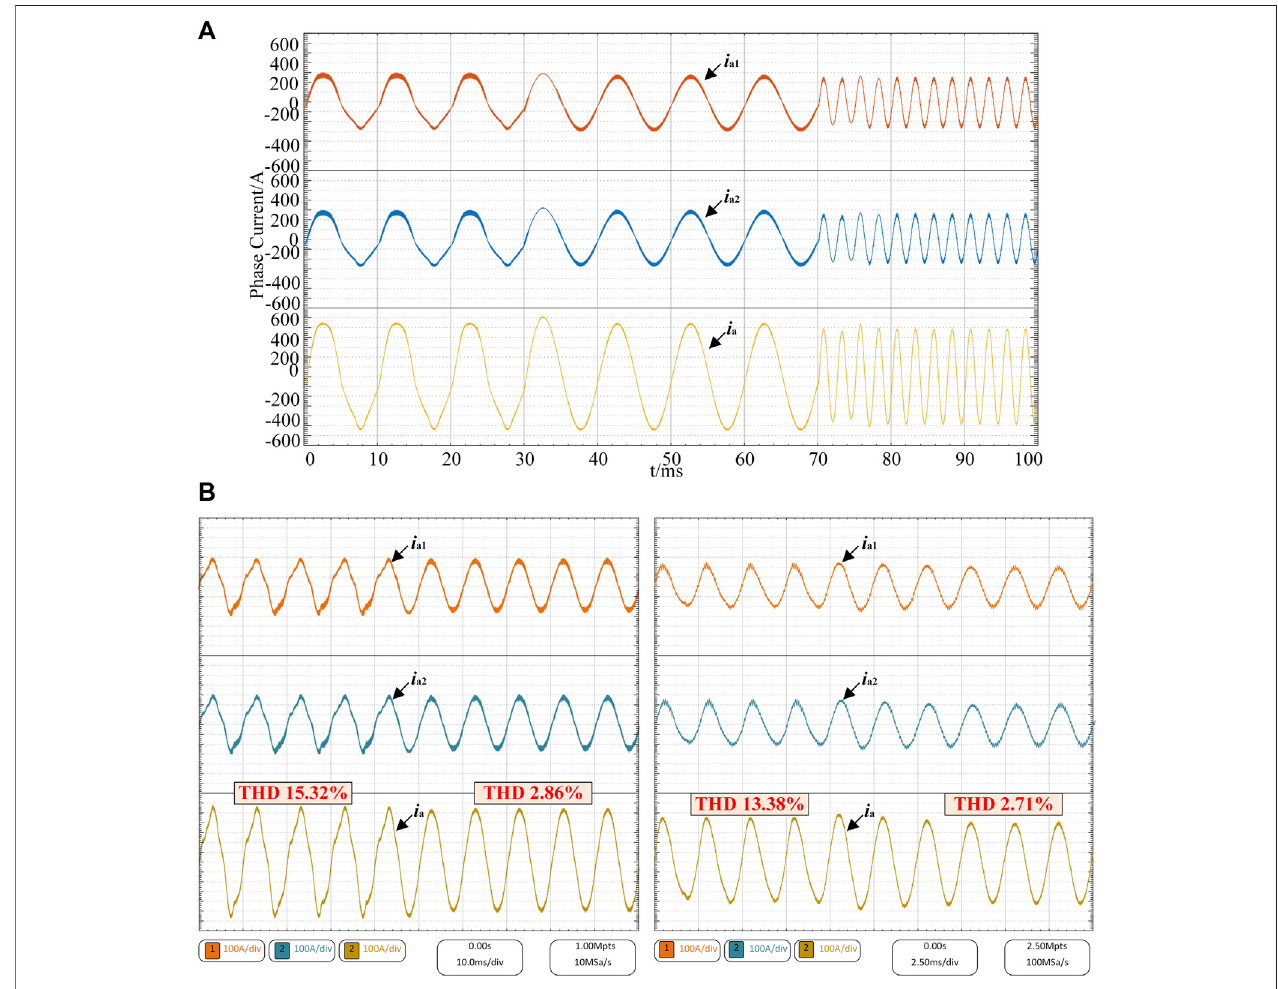
FIGURE 14 | Waveforms of phase currents: (A) simulation, (B) experimentation.